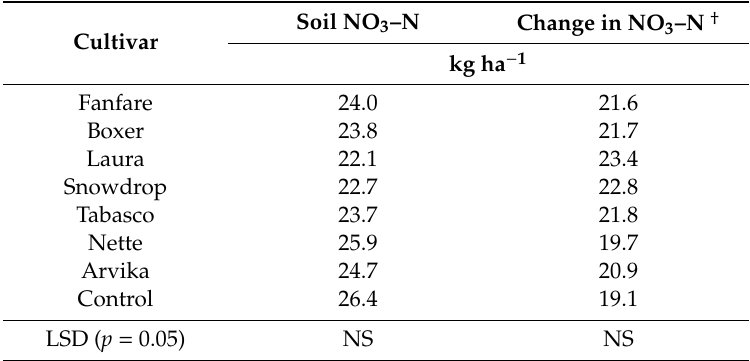
Table 9. End of season soil NO 3 –N and change in soil NO 3 –N throughout the life of the cover crop averaged across four environments at Hickson and Prosper, ND, in 2017 and